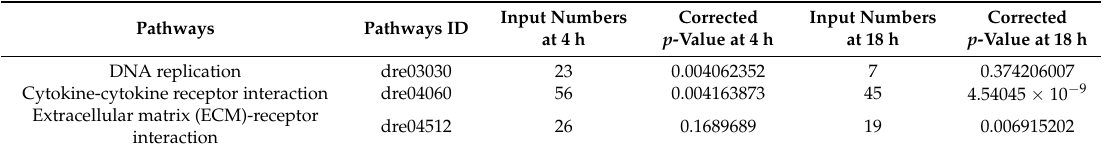
Table 2. The significant enrichment pathways at different time points. The pathway ID was obtained from the Kyoto Encyclopedia of Genes and Genomes (KEGG) database. A corrected p -value < 0.05 were used to identify significantly enriched pathways.